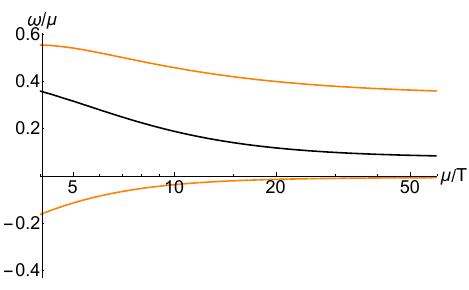
Figure 2 . The crossover between the diffu- sive and gapped mode at different µ/T . The black line is k/µ , and the dashed orange line is Im[ ω ] /µ , at crossover where the two modes are equally long-lived. The solid orange line shows Re[ ω ] /µ of the gapped plasmon mode at the